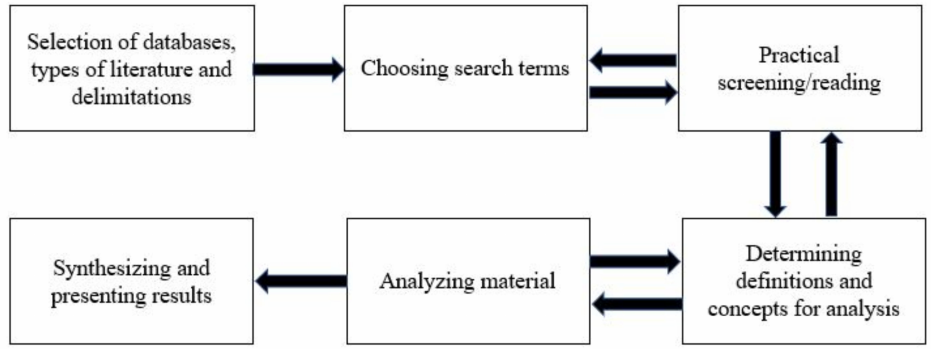
Figure 2. Process of a literature review (designed by the authors, based on